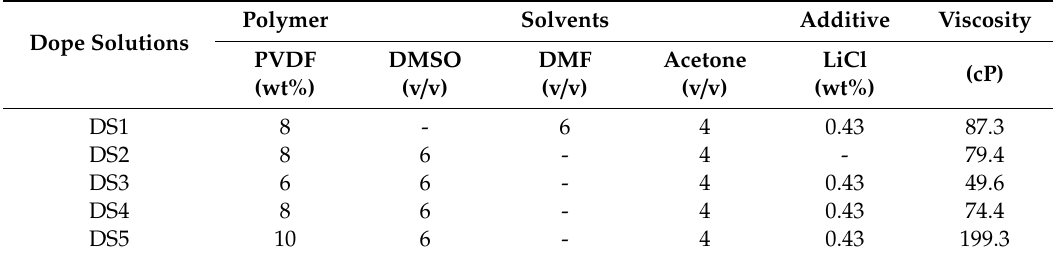
Table 2. Viscosity of the dope solutions prepared in this